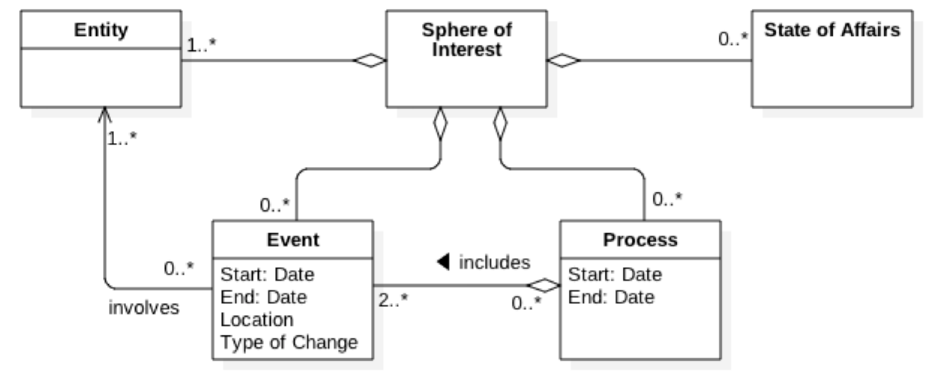
Figure 2. Sphere of Interest. The Sphere of Interest specifies what Entities, Events and States of Affairs are thought to be relevant in a Target Past. It may also include Processes, which are sets of related Events.